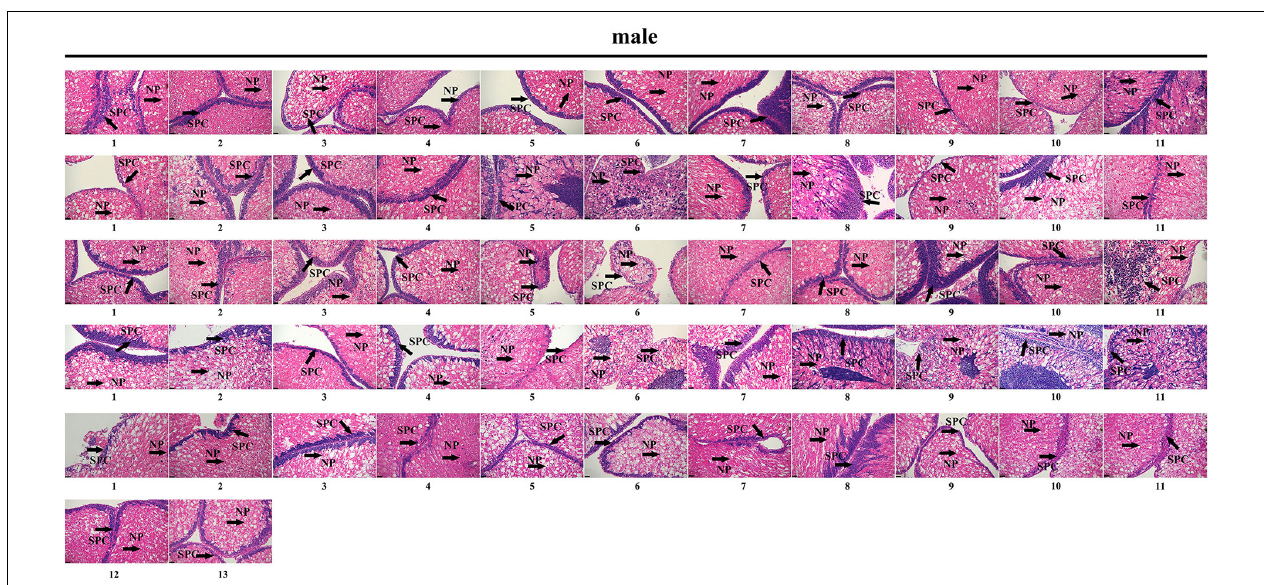
FIGURE 4 | Identification of 57 males by histological detection of gonads in the breeding population. NP, nutritive phagocytes; SPC,